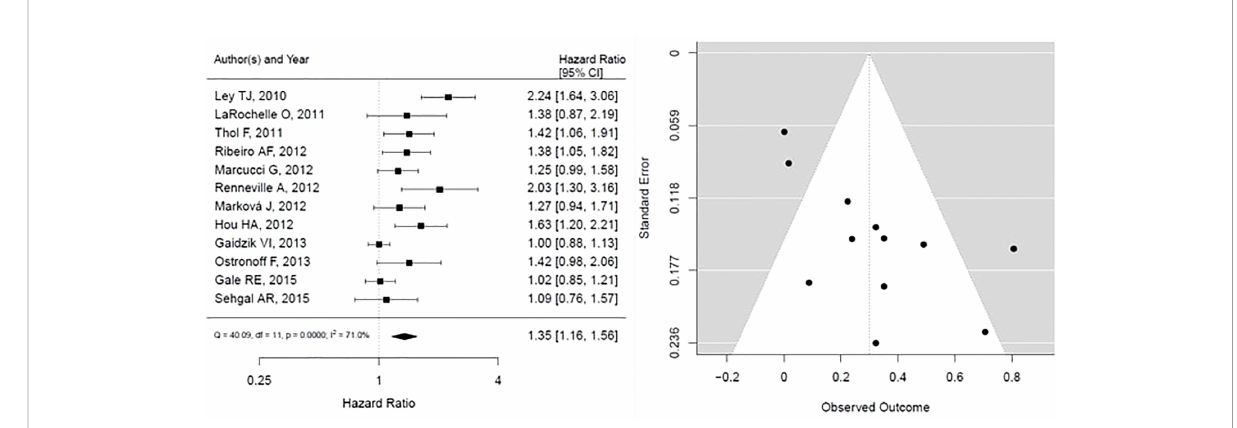
FIGURE 4 Forest plot and funnel plot of the HR for overall survival in DNMT3a mutation. The fi rst author and year of publication is provided for each study. The hazards ratio (boxes) with 95% con fi dence intervals (CI, horizontal lines) were calculated, the pooled hazards ratio (diamond) was estimated using random effect model. The P value for comparing heterogeneity between subgroups was calculated using I-squared. DNMT3A, DNA Methyltransferase 3 Alpha.